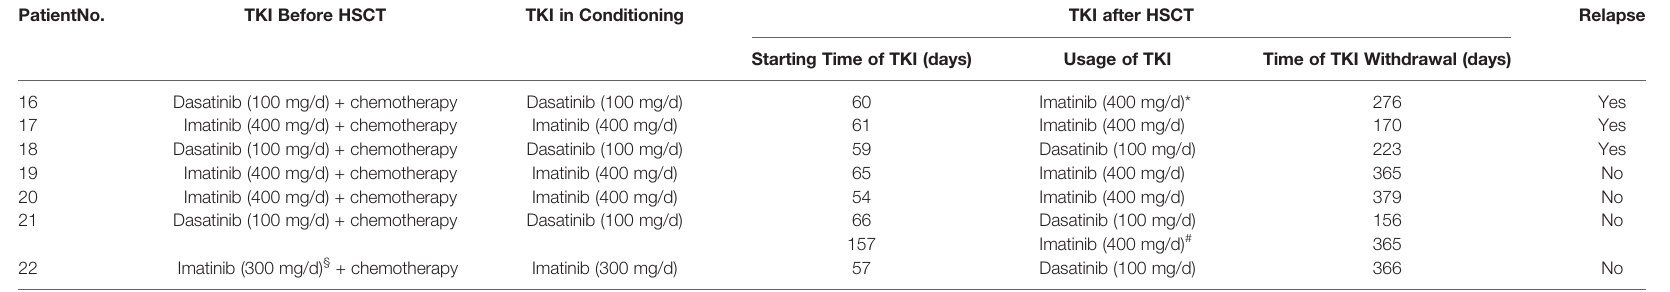
TABLE 3 | Use of TKI in 7 Patients with Ph + ALL. PatientNo.